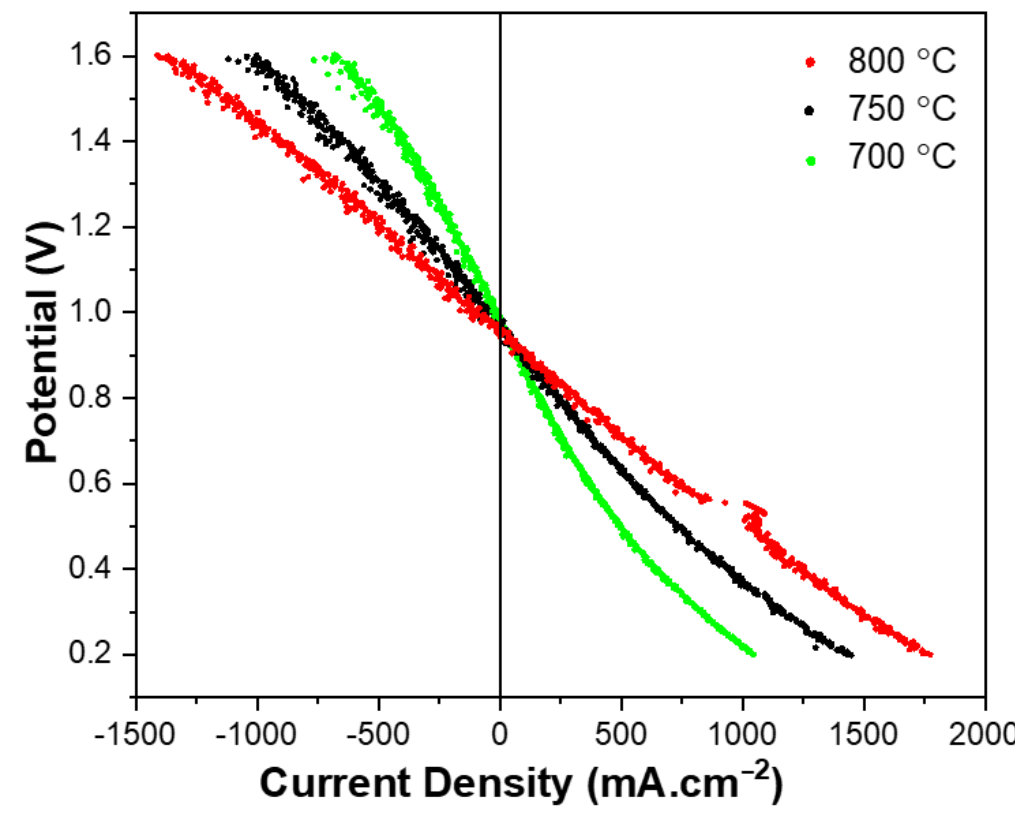
Figure 6. Current-Voltage characteristics of the MT-SOC operating in reversible mode, in a temperature range of 700 °C to 800 °C.